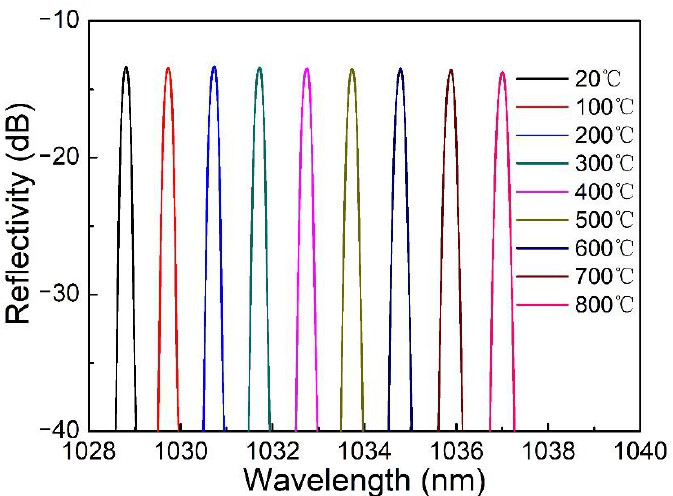
Figure 5. The reflection spectrum of an apodized FBG with a core diameter of 4.4 μm varies with temperature.